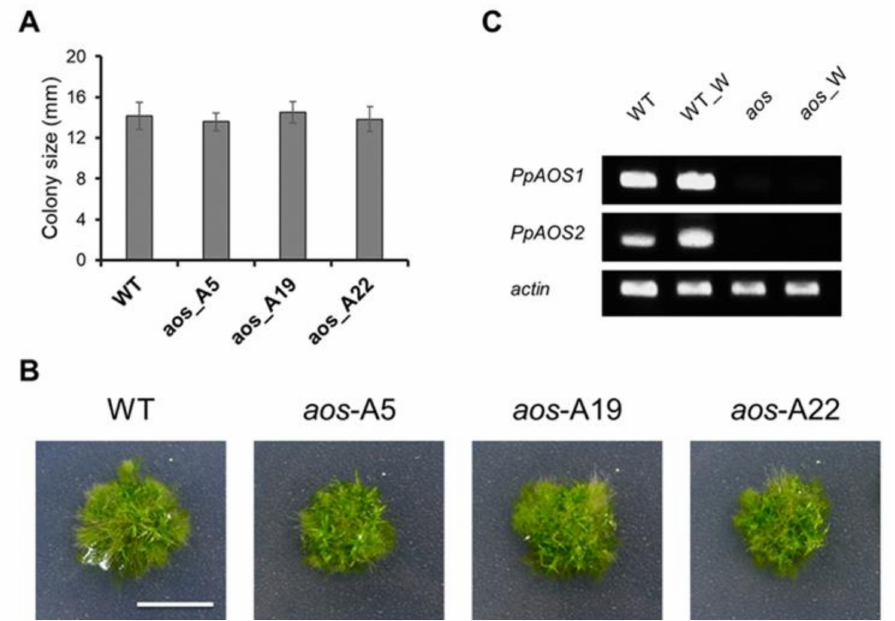
Figure 2. Phenotypic analysis of the wild-type and aos mutant of P. patens . The wild-type and the aos mutants of P. patens were grown on BCDAT agar for 3 weeks, and their phenotypes were compared. ( A ) Colony size of the wild-type and aos mutants of P. patens (the values are the mean ± SD, n = 12). A significant di ff erence was not found between wild-type and mutants (Student’s t-test). ( B ) Images of the wild-type and aos mutants of P. patens . White size bar represents 1 cm length. ( C ) Semi-quantitative RT-PCR of PpAOS gene expression after wounding in the wild-type and aos mutant (A5 strain). WT and aos as control, without wounding treatment; WT_W and aos_W as wounded group: gametophores of P. patens (WT and aos mutant) were wounded using tweezers and harvested 1 h later for RNA isolation. The gels were stained using ethidium